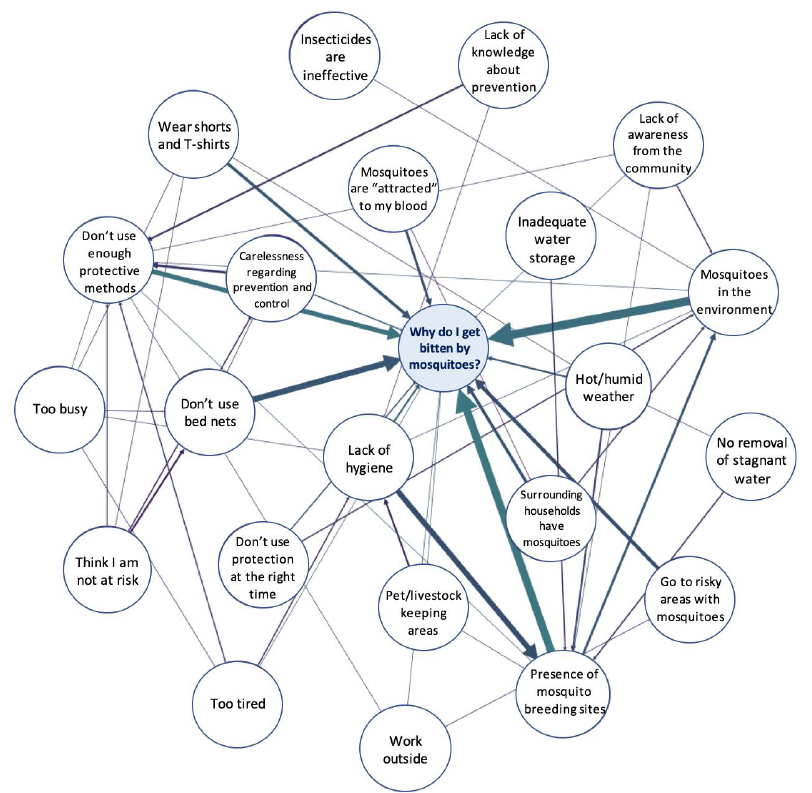
Figure 1. Aggregated map of determinants of mosquito control in households in Hanoi, Vietnam. The thickness of each edge is proportional to its weight, i.e., the number of participants who identified this link. Trop. Med. Infect. Dis. 2020 , 5 , x FOR PEER REVIEW Table 5. Network statistics of key determinants.